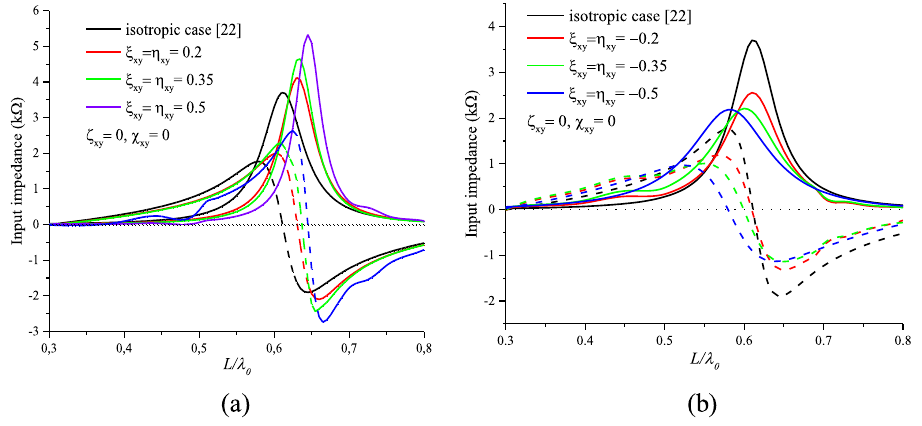
Figure 8. Effects of ( a ): Positive-reciprocal chirality and ( b ): Negative-reciprocal chirality on the input impedance of the printed dipole.